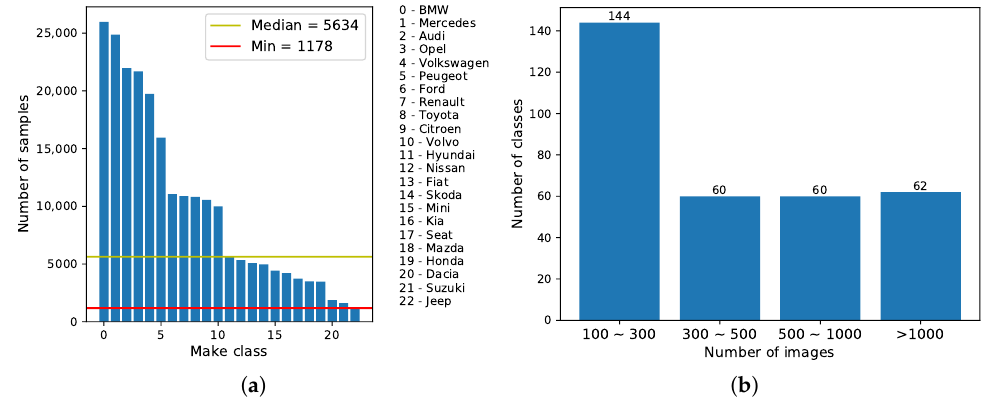
Figure 2. ( a ) Distribution of make classes in new DVMM dataset. The red line marks the minimum number of samples corresponding to 1178. The yellow line marks the median number of samples corresponding to 5634. The 23 vehicle make class labels are presented on the right side. ( b ) The four-bin histogram of the 326 vehicle model classes in